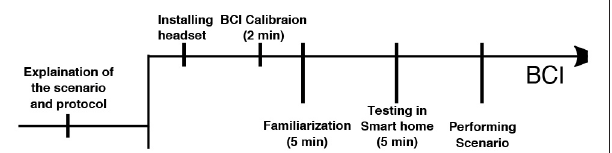
FIGURE 5 | Timeline for the experiments. “Familiarization” phase let the users test the BCI without any actuation of the smart home appliances. The